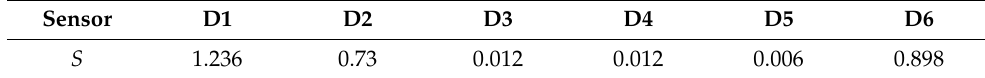
Table 3. The forecast deviation value S of each information